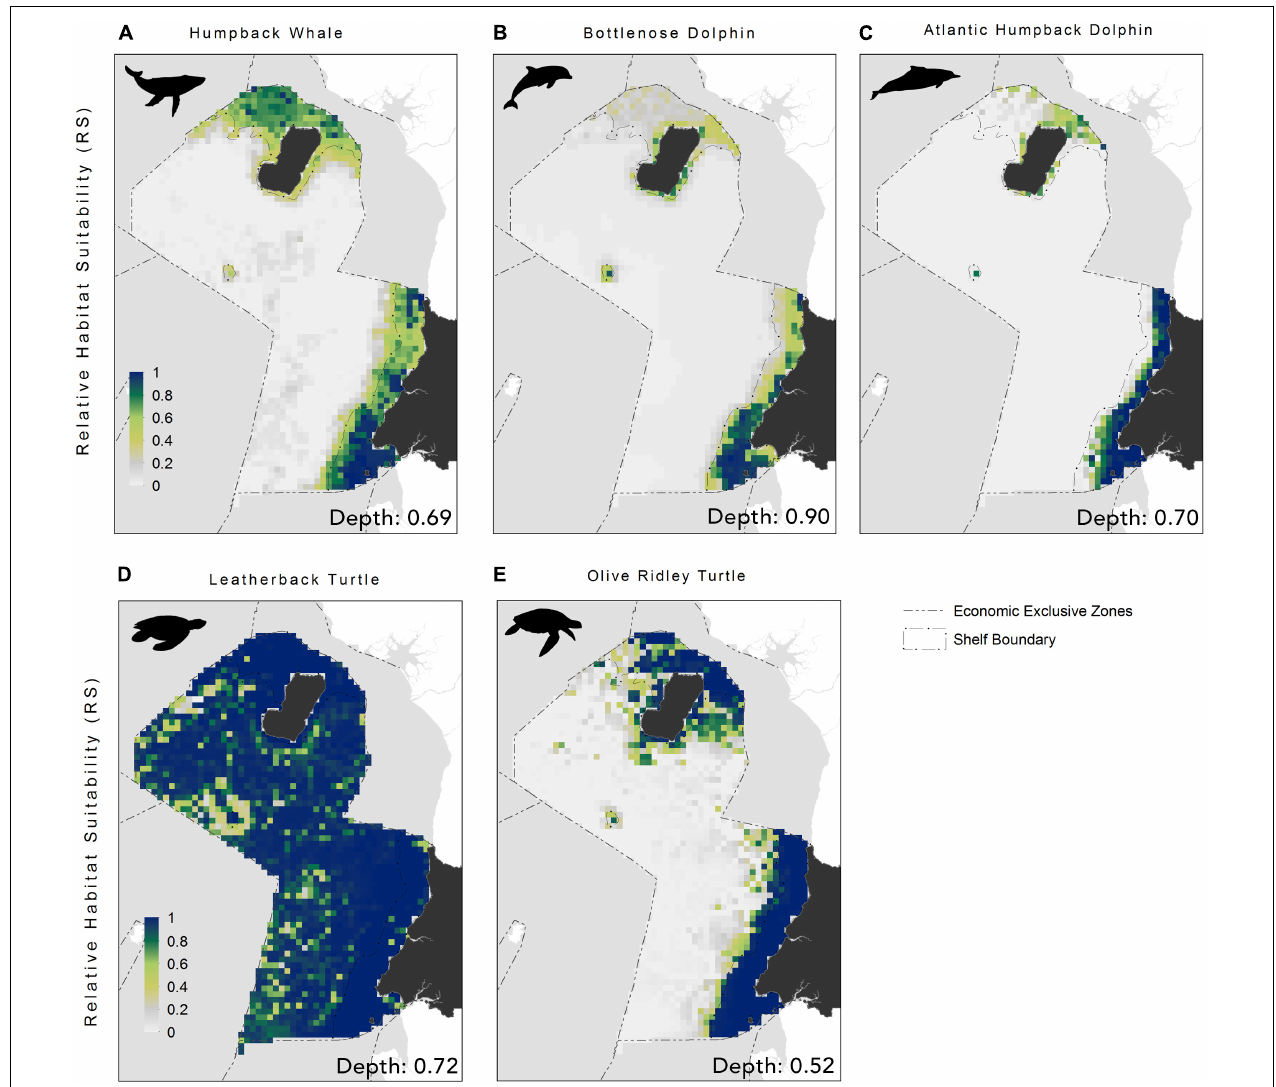
FIGURE 2 | Relative habitat suitability models for: (A) humpback whale; (B) bottlenose dolphin; (C) Atlantic humpback dolphin; (D) leatherback turtle, and (E) olive ridley turtle within the Bioko-Corisco-Continental area of Equatorial Guinea’s exclusive economic zone. Relative suitability (RS) of habitats, is scaled between 0 and 1, where 0.5 represents areas of typical habitat suitability, 0 represents lowest suitability and 1 indicates greatest suitability. Environmental variable value for depth (the most important variable for all species) is listed on the bottom-right of each map; see Supplementary Table S5 for additional variables and their importance values. See Figure 1 for additional geographical information for the Bioko-Corisco-Continental area of Equatorial Guinea’s exclusive economic